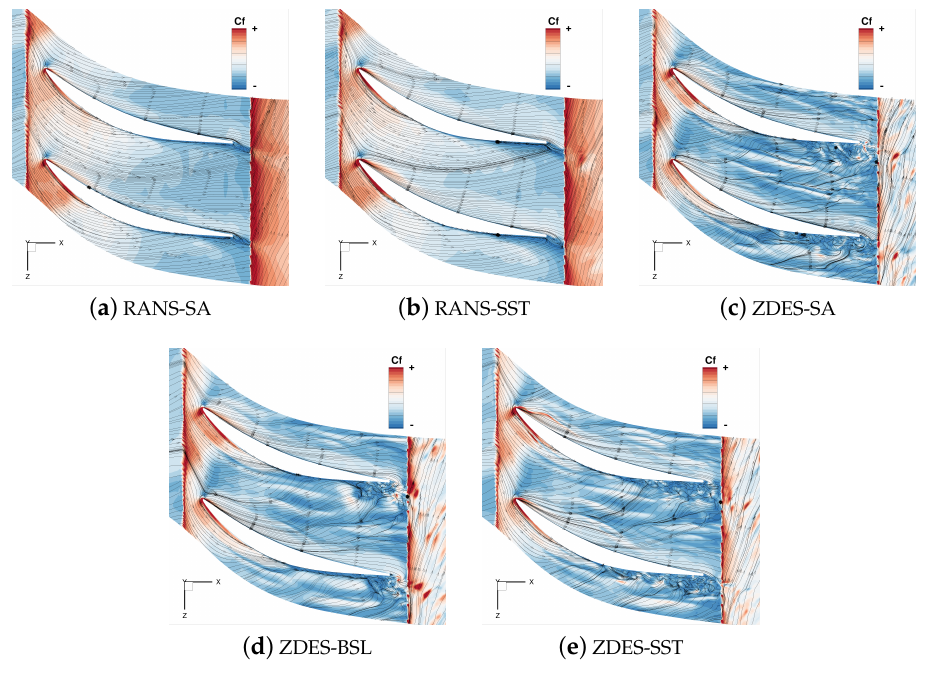
Figure 14. Skin-friction magnitude and skin-friction lines over the hub at t = T /2. As all walls are adiabatic, the entropy variation is a good sensor of losses within a